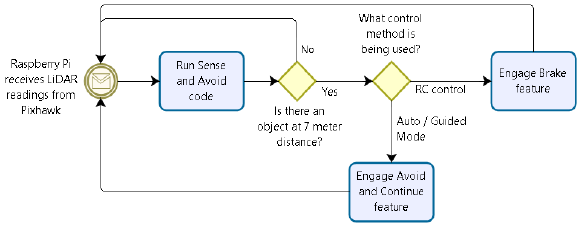
Figure 1. “Sense and Avoid” internal